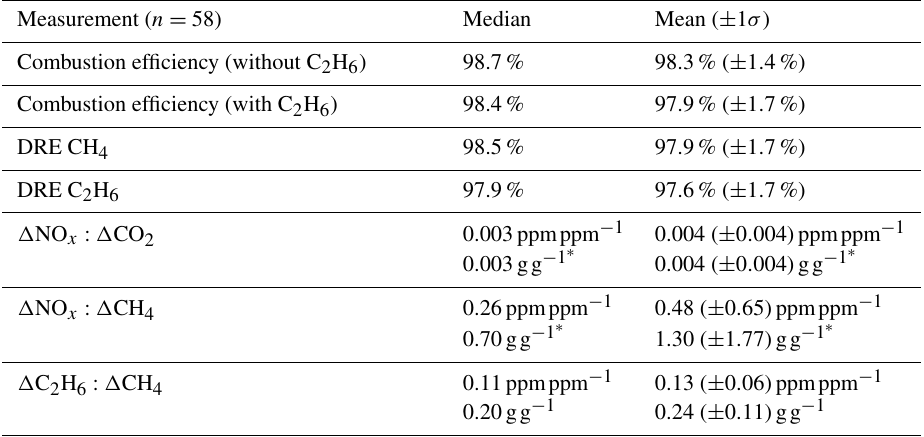
Table 1. Summary of combustion efficiency, destruction removal efficiency (DRE), and emission ratio results.